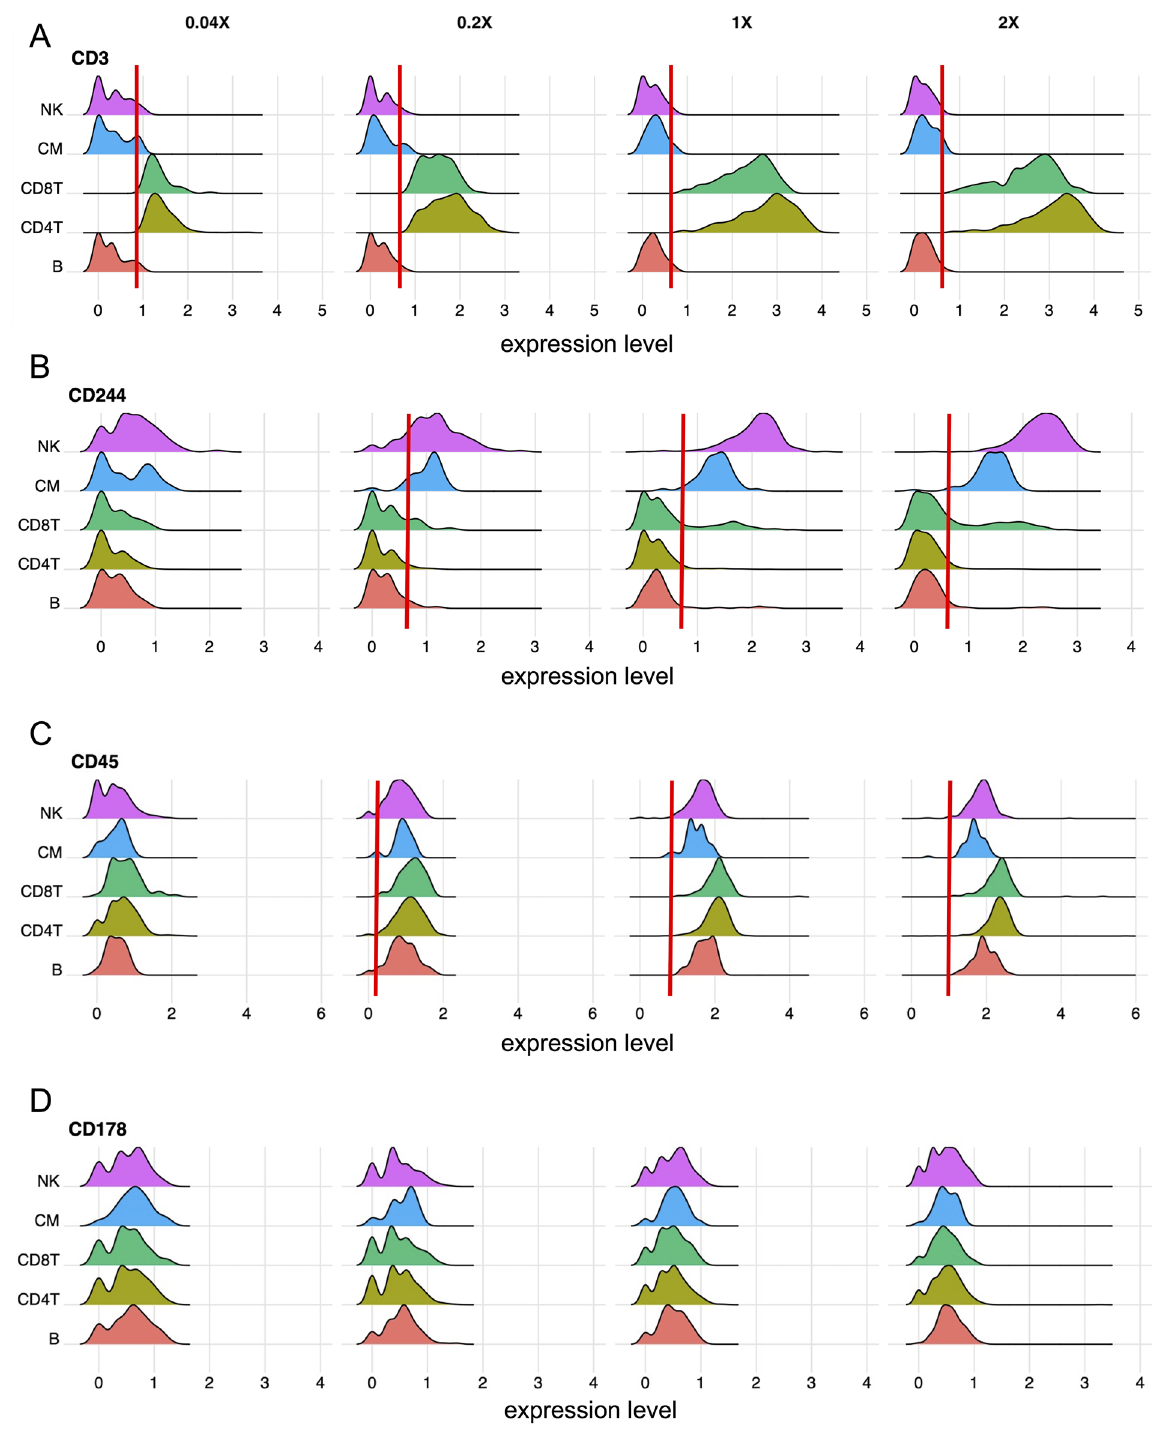
Figure 2. Exemplary ridge plots used to threshold antibodies and to evaluate antigen expression. ( A ) shows an exemplary antigen (CD3) which was detectable at all dilutions. In contrast, CD244 shown in ( B ) was not detected at the lowest concentration (0.04 ×). ( A , B ) Antibody thresholds, indicated with red lines, were set to the upper limits of negative populations. ( C ) Some antigens, such as CD45, were detectable in all cells, as expected. Thus, negative populations did not exist. Here, antibody thresholds (red lines) were set to the lower limits of positive populations. If a considerable amount of expression values and the lower limit of the populations were negative, thresholds were not called (as for the 0.04 × concentration in the CD45 example). The exemplary antigen (CD178) shown in ( D ) was not detectable at any concentration. ( A – D ) Expression values were centered log-ratio (CLR)